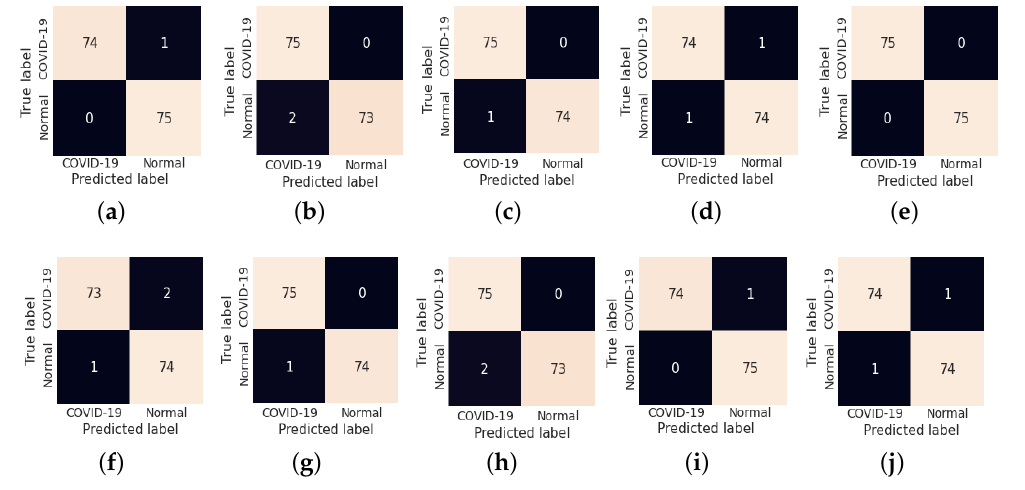
Figure 6. ( a – j ) Confusion matrix obtained by LW-CORONet fold-wise (fold 1 to fold 10) for binary classification